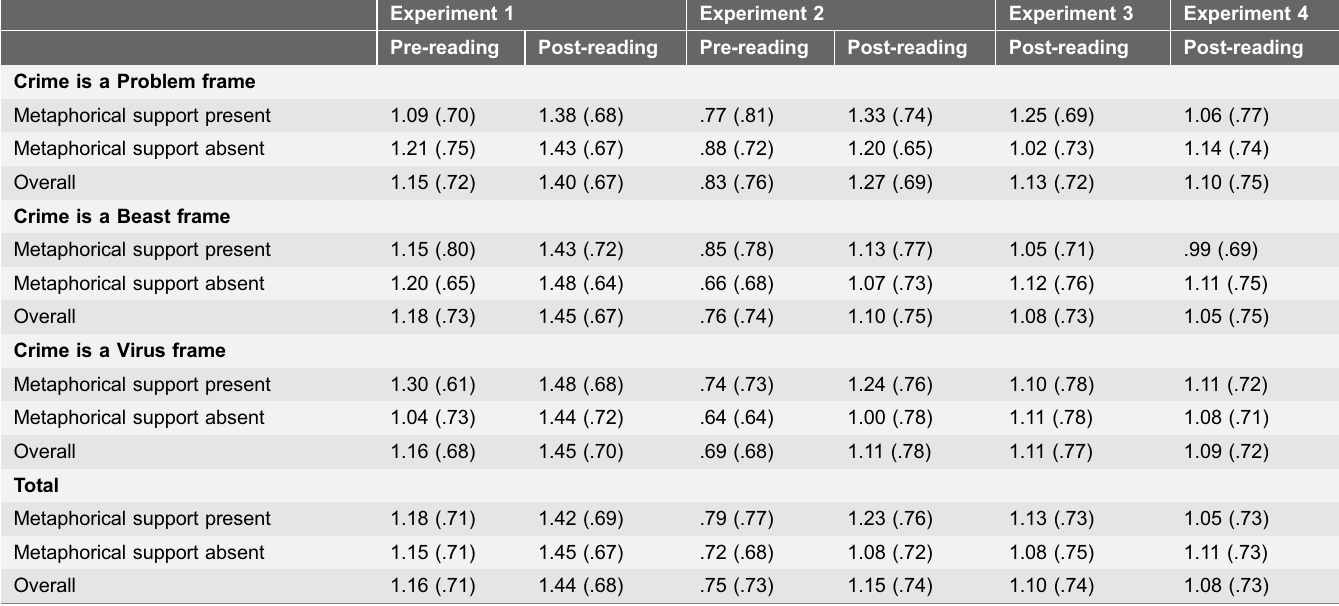
Table 2. Experiments 1–4: Mean scores (and standard deviations) of preference for enforcement-oriented or reform-oriented policy measures as a factor of the metaphorical framing (problem, beast, virus), metaphorical support (present, absent) and, for Experiments 1–2, exposure (pre or post-reading of stimulus text), based on the top 2 of preferred